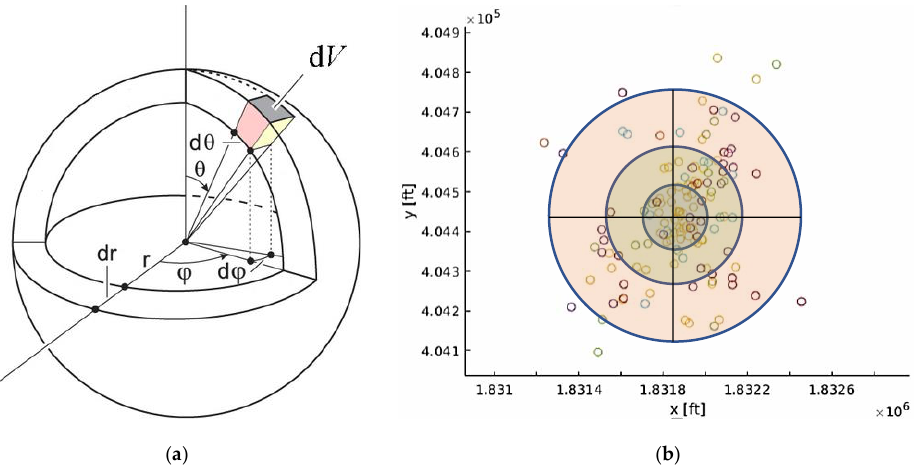
Figure 17. An algorithm for tracking the growth direction of SRV. ( a ) Conceptual sphere representing the SRV growth in a homogeneous and isotropic condition (picture adapted from [31]) and ( b ) 2D representation of the observed MS events and their corresponding time-laps (color-coded) showing the SRV growth.